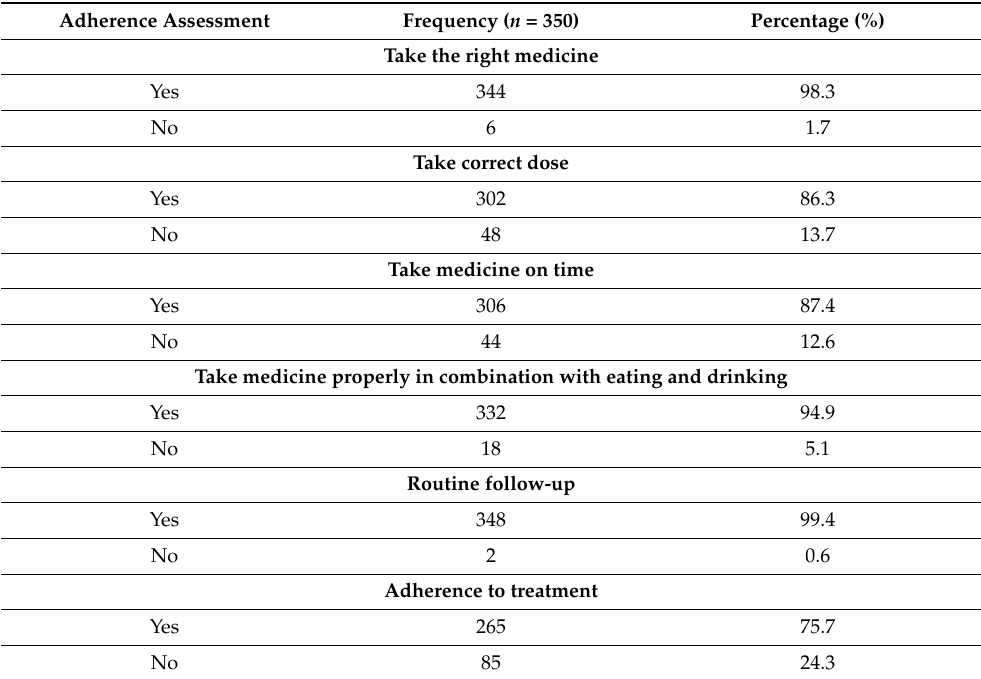
Table 2. Adherence to antiretroviral therapy (ART) among patients with HIV.